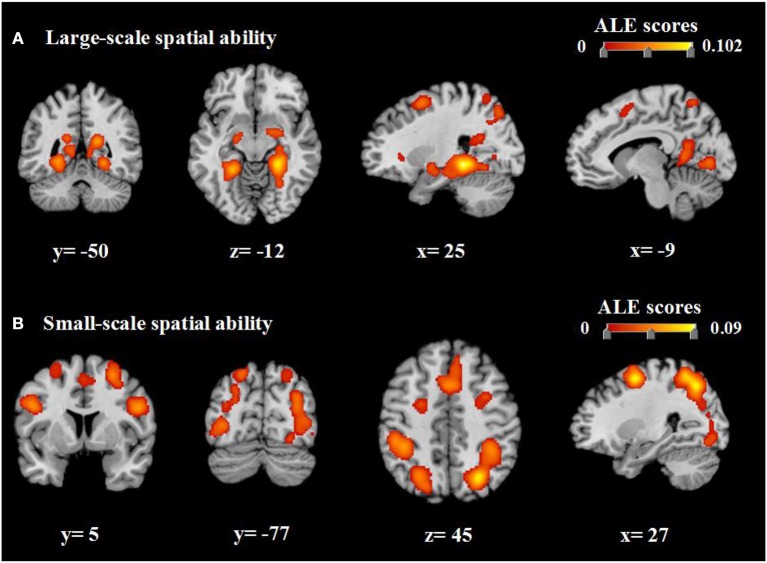
ALE meta-analysis of neuroimaging studies regarding large-scale spatial ability (A) and small-scale spatial ability (B). Coordinates are presented in millimeters (mm). ALE, activation likelihood estimation.